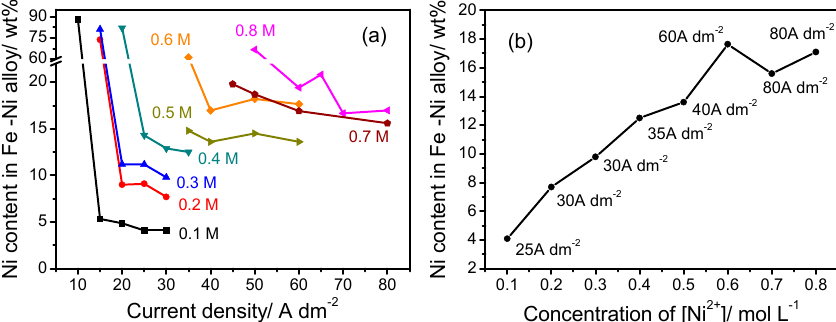
Figure 5. The effects of ( a ) current density and ( b ) concentration of Ni 2+ ions on Ni content in Fe–Ni alloy foils.